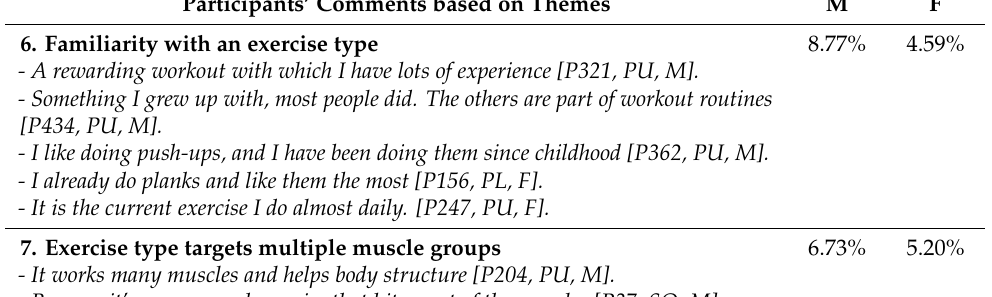
Participants’ Comments based on